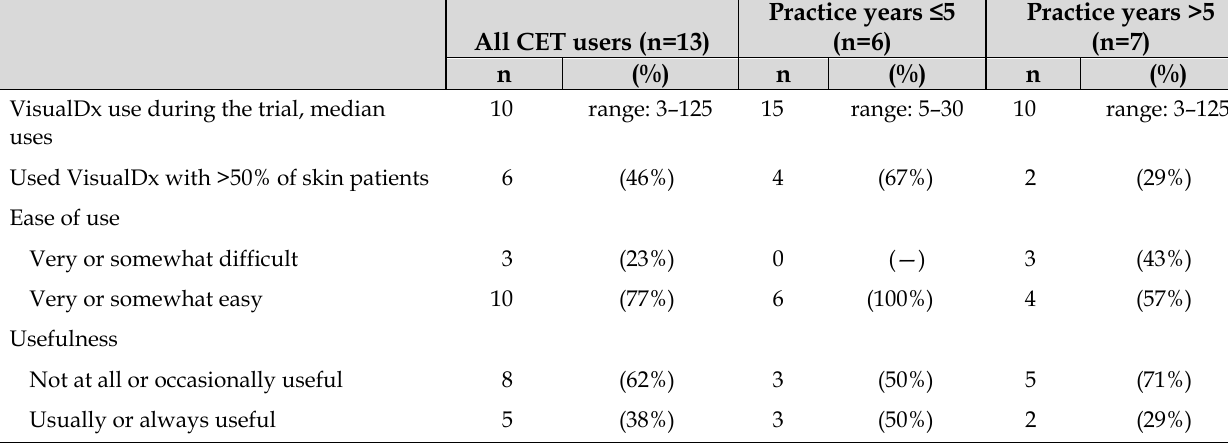
Table 2 CET frequency of use, ease of use, and usefulness, depending on years in